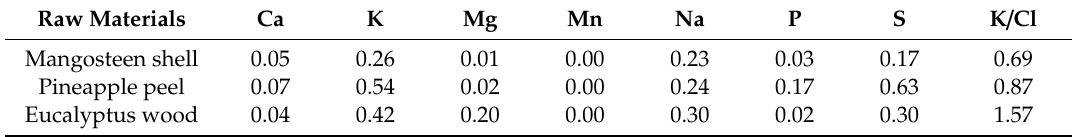
Table 4. The proportions of water soluble elements in biochars a and the molar ratio of dissolved K / Cl. Raw Materials Ca K Mg Mn Na P K / Cl Mangosteen